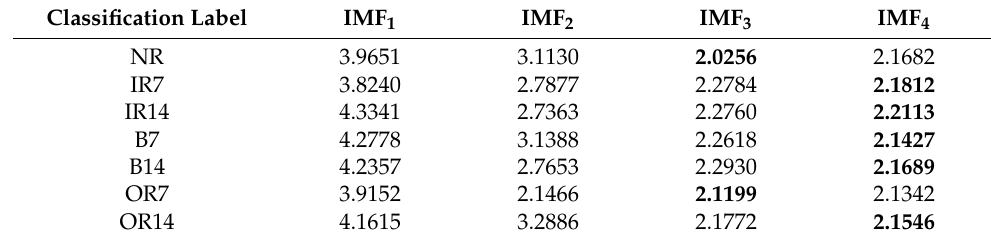
Figure 4. K = 4 result of VMD of IR. Lower entropy values lead to lower dispersion degrees of the data. The modal component with a minimum entropy value in each fault state signal is selected for subsequent research. The entropy values of modal components of each fault type are shown in Table 2. The minimum modal components of each fault type are selected and highlighted in bold. The data of seven fault types are selected respectively: IMF3, IMF4, IMF4, IMF4, IMF4, IMF3, and IMF4. Table 2. The entropy of IMF 1 – IMF 4 .